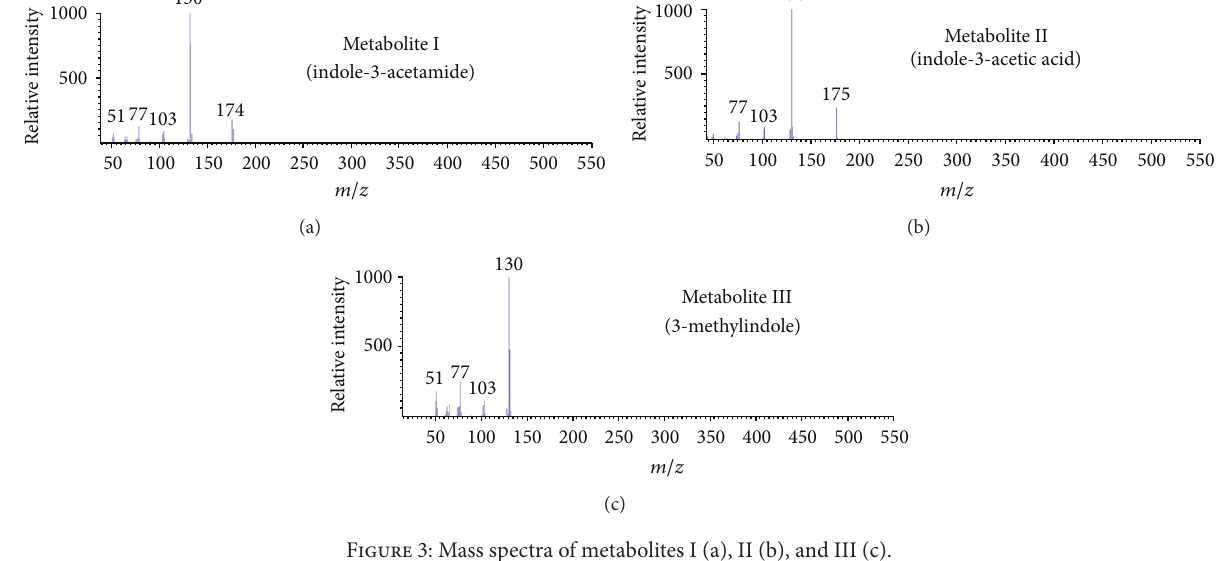
Figure 3: Mass spectra of metabolites I (a), II (b), and III (c).